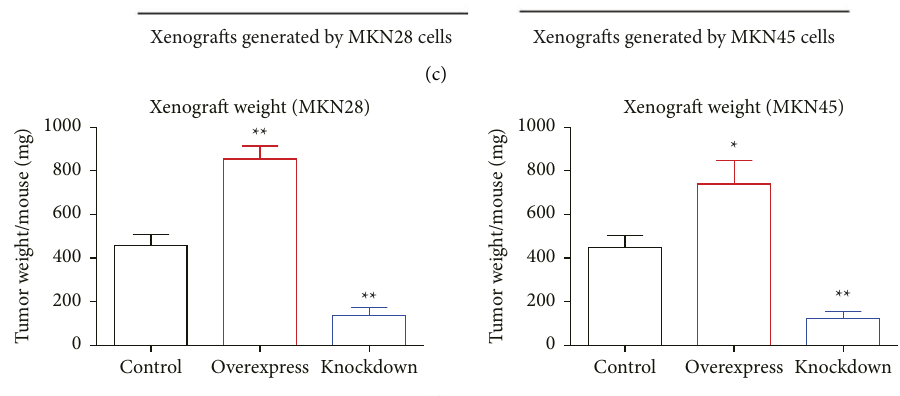
Figure 4: SLC39A1 promoted gastric adenocarcinoma growth in vivo . Transfected MKN28 or MKN45 cells were subcutaneously injected into nude mice and then the mice weight (a) and xenograft volumes (b) were monitored every fve days. Tree weeks after cell injection, all mice were sacrifced to isolate the xenografts for picturing (c) and weighting (d). Data were presented as mean ± SD from three independent repeats. ∗ indicates P < 0 . 05 by Student’s t -test compared with vector control